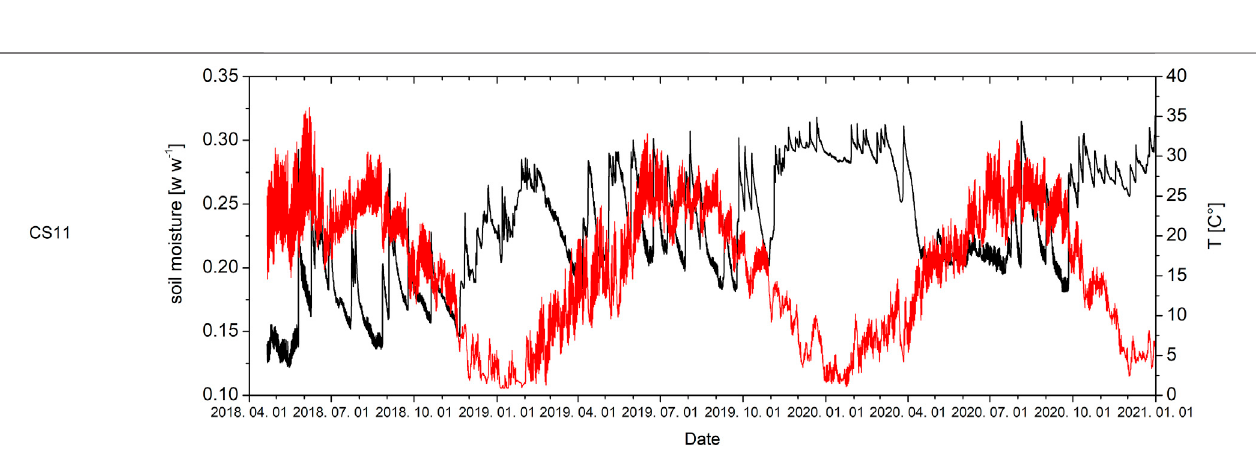
FIGURE 13 | Temperature (red line, right axis in ° C) and soil moisture (black line, left axis in VWC m3/m3) of CS 11 during the three growing seasons (%).